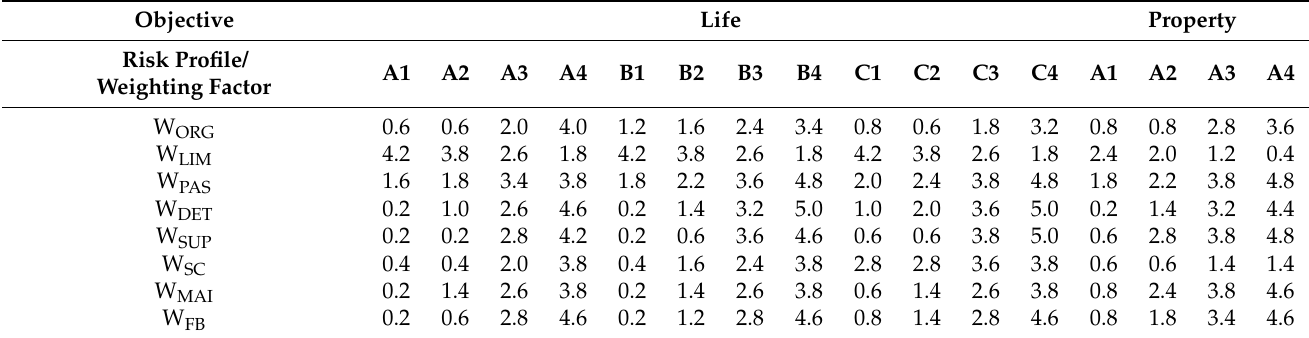
Table 5. Weighting factors appropriate for building risk profiles [40,41].